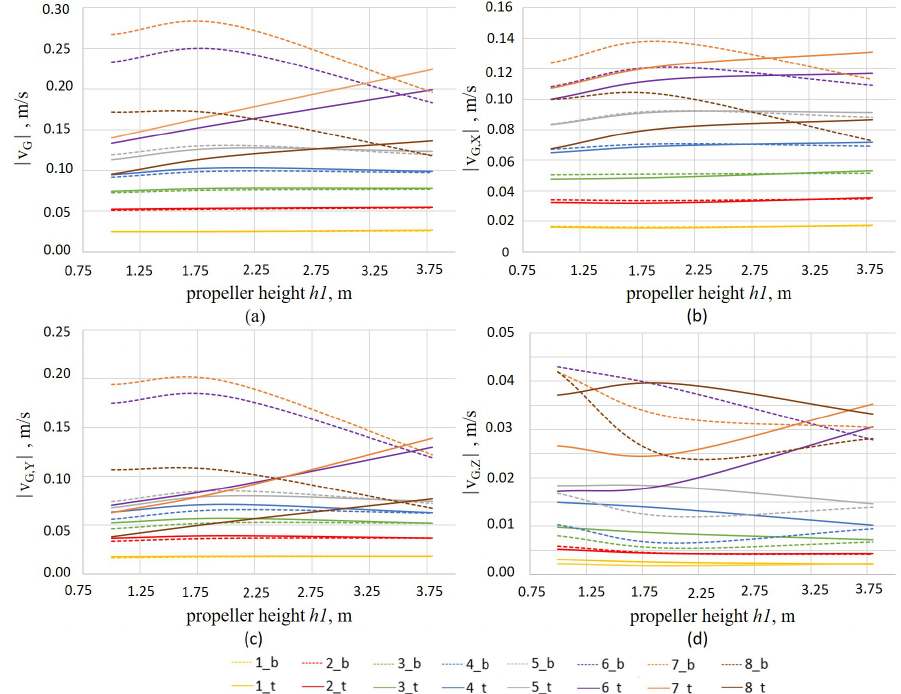
Fig. 5. Dependency of (a) global fluid velocity v G and axial components (b) x, (c) y, and (d) z with the height of propeller 1 ( h1 ). Profiles refer to 8 bottom (#_b, dotted lines) and 8 top (#_t, continuous lines) circular subregions (see Fig.